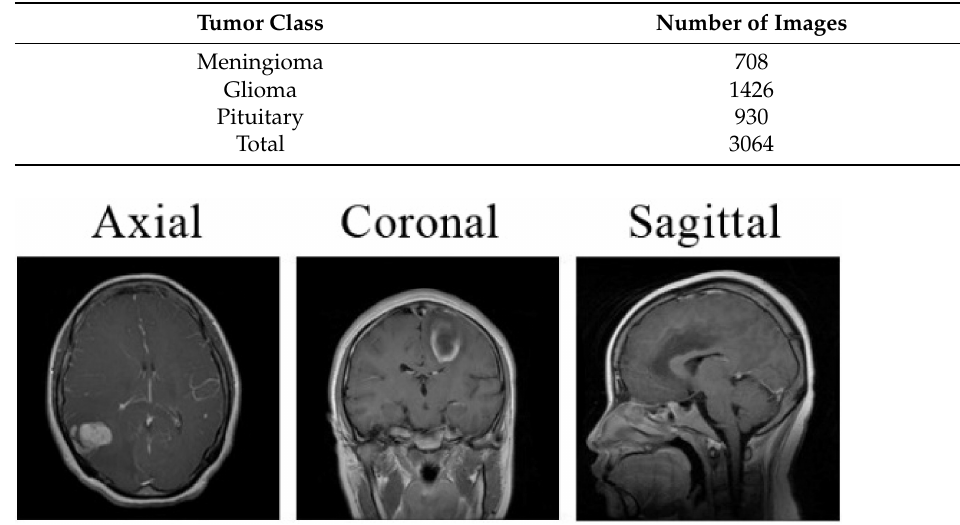
Table 1. The dataset used for the proposed approach.